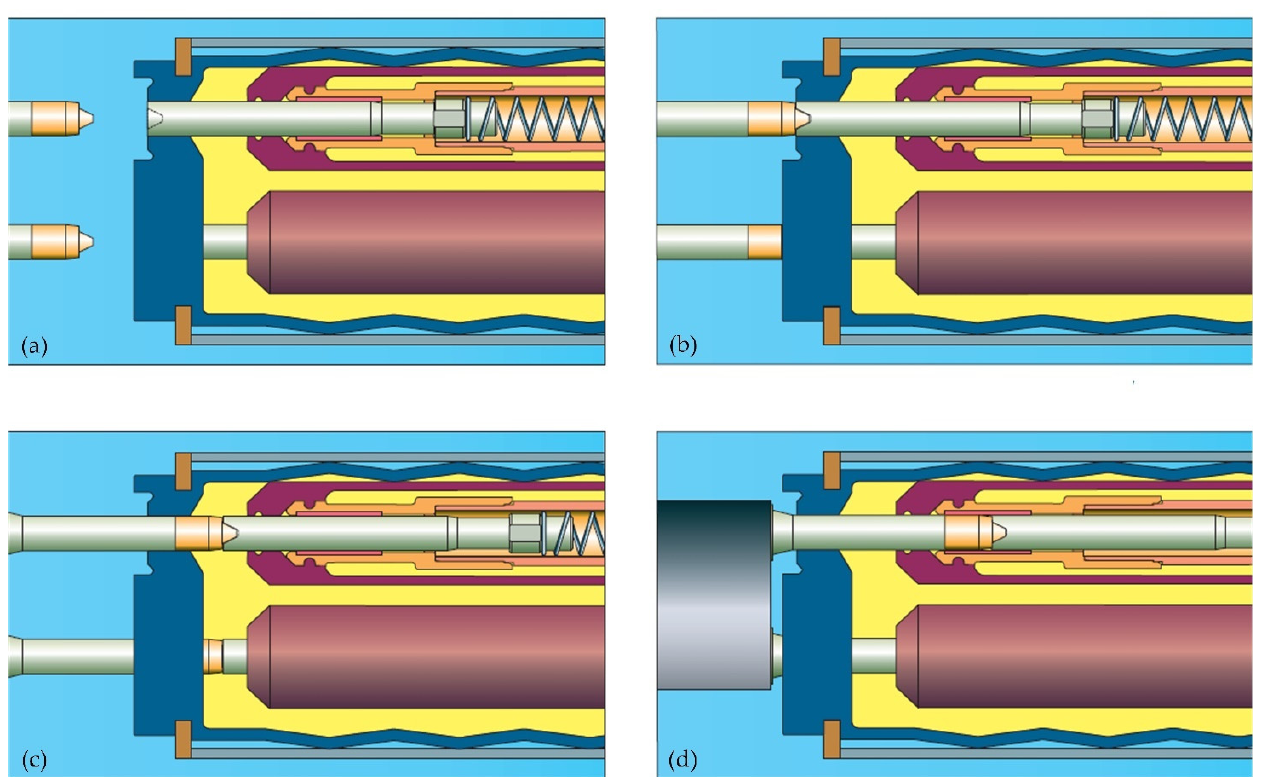
Figure 13. The shuttle pin design with dual-bladder PBOF technology of Siemens DigiTRON: ( a ) plug and receptacle prior to mating, ( b ) pin of plug engages with the shuttle pin (stopper) of receptacle, ( c ) pin of plug enters first oil chamber of the primary bladder and pushes back the shuttle pin, and ( d ) pin of plug enters second-ary oil chamber of the secondary bladder and makes full contact with receptacle [89].